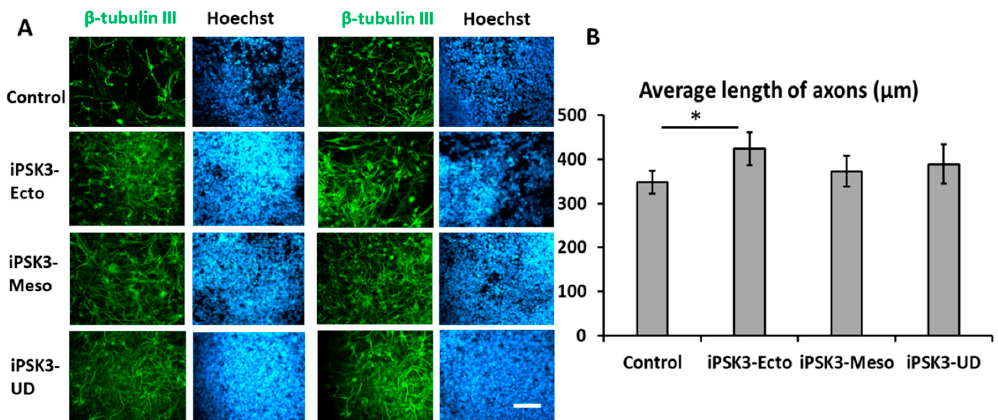
Figure 5. Effects of hiPSC-derived EVs on axonal growth of iNPC spheroid outgrowth by β -tubulin III staining. Day 25 cortical spheroid outgrowth was treated with different groups of hiPSC-EVs for three days before the analysis. The length of each axon was quantified by ImageJ software. Twenty axon lengths were averaged for each image. Three images were analyzed for each group. The data from the three images were averaged to give the overall average axon length. ( A ) Fluorescent images of β -tubulin III positive cells; Blue: Hoechst. ( B ) Quantification of axon length indicated by β -tubulin III expression. Scale bar: 100 µm. * indicates p < 0.05 compared to the control condition. Cells 2019 , 8 , x